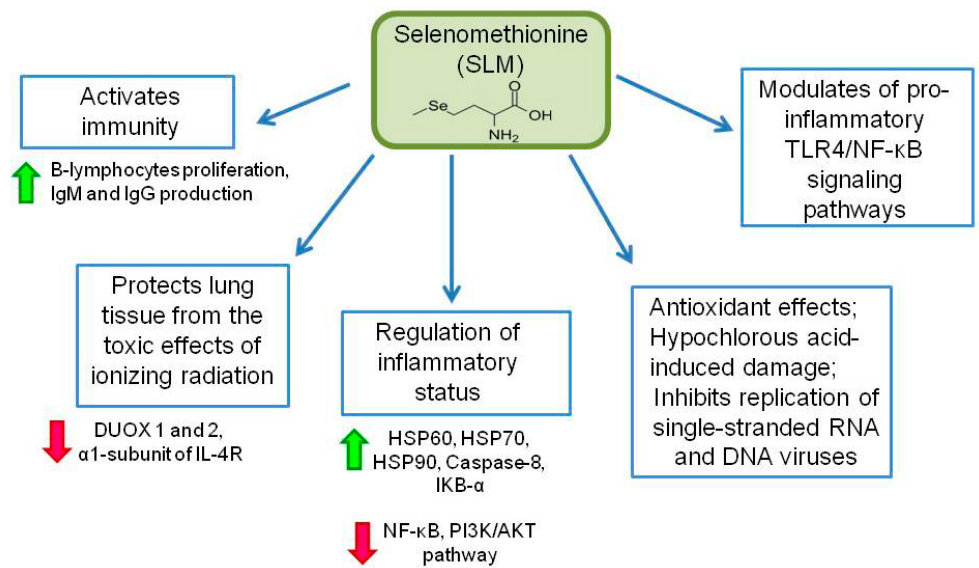
Figure 4. Role of selenomethionine in immune system activation. IgM and IgG—immunoglobulins M and G; DUOX 1 and 2—dual oxidase 1 and 2; IL-4R—interleukin-4 receptor; HSP60, 70 and 90—heat shock proteins 60, 70 and 90; IKB- α —nuclear factor of kappa light polypeptide gene enhancer in B-cells inhibitor, alpha; NF- κ B—nuclear factor kappa-light-chain-enhancer of activated B cells; PI3K/AKT—PI3K-PKB/Akt pathway, protein kinase B (PKB or AKT) and phosphoinositide-3-kinase (PI3K); TLR4—toll-like receptor 4. Expression enhancement is indicated by green arrows and suppression by red arrows.